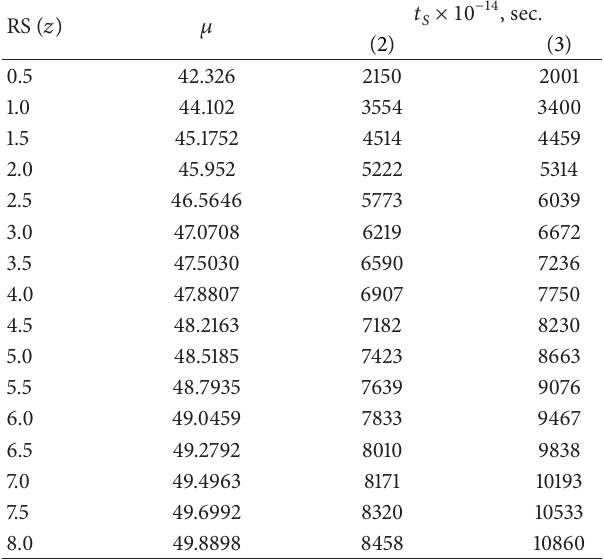
Table 1: RS/ 𝑡 𝑆 data calculated with (2), (3), and